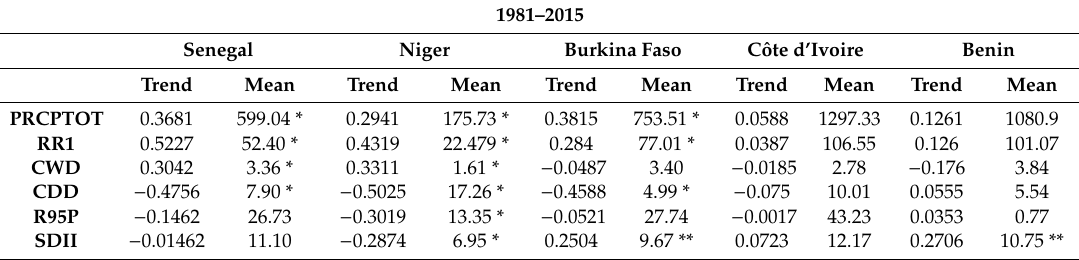
Table 3. Trend and mean values of PRCPTOT (mm per year and mm, respectively), RR1 (days per year and days, respectively), CWD (days per year and days, respectively), CDD (days per year and days, respectively), R95P (mm per year and mm, respectively), and SDII (mm / day per year and mm / day, respectively) averaged over each country. The significant results are indicated with the symbols ‘*’ when the Mann–Kendall test is highly significant (99% confidence level) and ‘**’ when it is significance (95% confidence